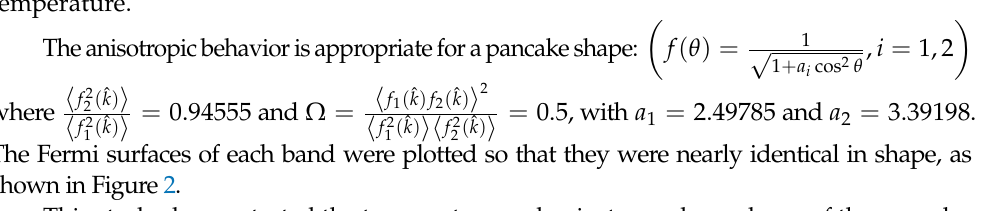
Figure 1. The H c 3 ( T ) and H c 2 ( T ) versus temperature ( T ) of K 0.73 Fe 1.68 Se 2 superconductor. )( TH H c 2 ( T ) TH 23 cc and )( Figure 1. The versus temperature (T) of K 0.73 Fe 1.68 Se 2 superconductor. c 2 )( TH ( T c ) ≈ 6.2 was higher than that reported The calculation in this study found that H c 3 H c 2 ( T c ) ( T c ) ≈ 4.4 [22]. However, the result showed the temperature dependence on H c 3 ( T ) by H c 3 H c 2 ( T c ) H c 2 ( T ) )( ( T ) The calculation in this study found that was higher than that re- value was higher than 1.66 for a well-known formula. As the temperature increases, H c 3 H c 2 ( T ) is decreased to the lowest value of 6.2. It was found that the magnetic parameters such ( T c ) as χ and χ (cid:48) showed a higher effect on H c 3 than the other parameters at the critical H c 2 ( T c ) [22]. However, the result showed the temperature depend- )( TH 3 c value was higher than 1.66 for a well-known formula. As the tempera- ence on )( TH 2 c ture increases, cc is decreased to the lowest value of 6.2. It was found that the